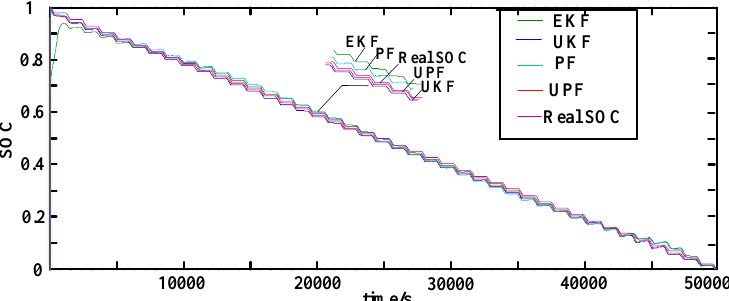
Figure 12. SOC Estimation curves of different algorithms at 25 °C. EKF, extended Kalman filter; UKF,